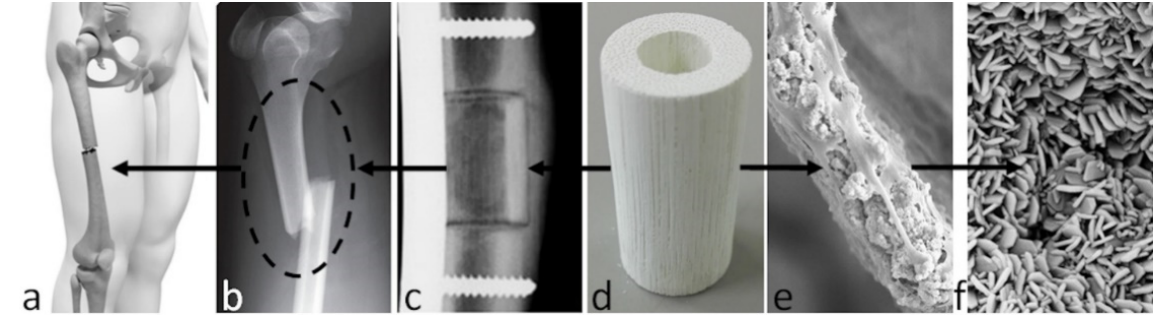
Figure 5. Biomorphic scaffolds for long bone regeneration and their application in long bone defects: ( a ) example of implantation site; ( b ) critical size defect; ( c ) radiography of implanted scaffold; ( d ) bone scaffold from wood; ( e ) scaffold–cell interaction, 250×; ( f ) scaffold nanostructure, 25,000×.